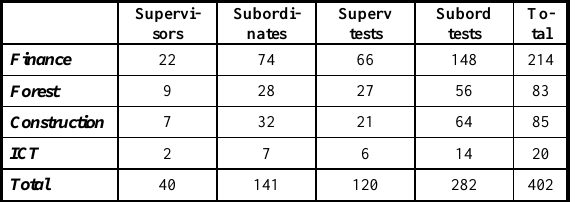
Figure 1. The research design of the present study. TABLE I. T HE NUMBER OF TESTS RUN WITHIN THE SAMPLE